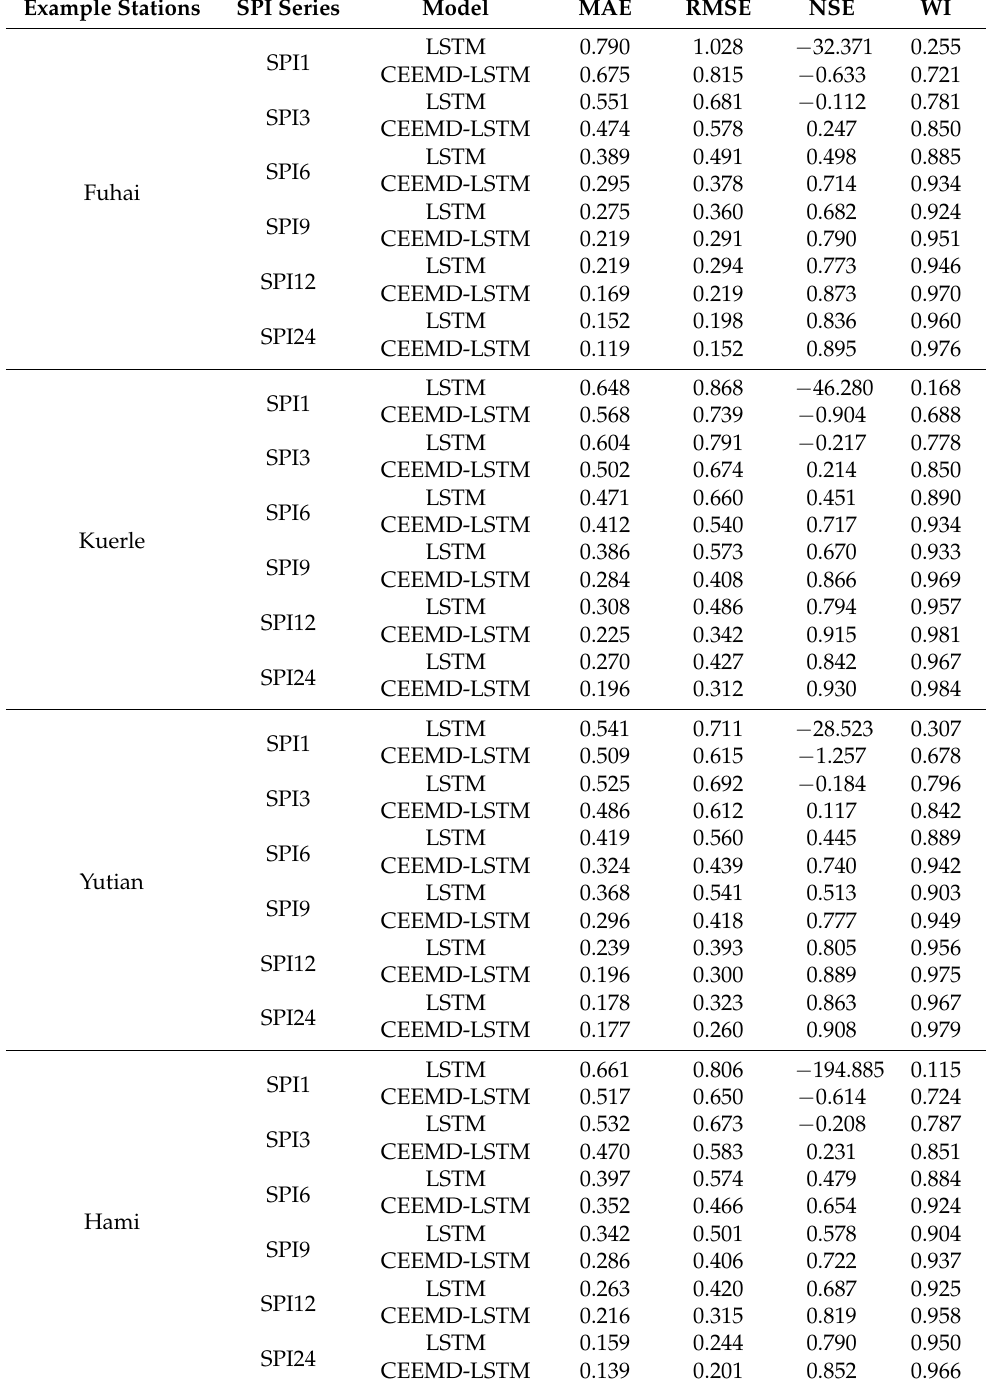
Table 3. Comparison of the observed and predicted values of the two models using statistical